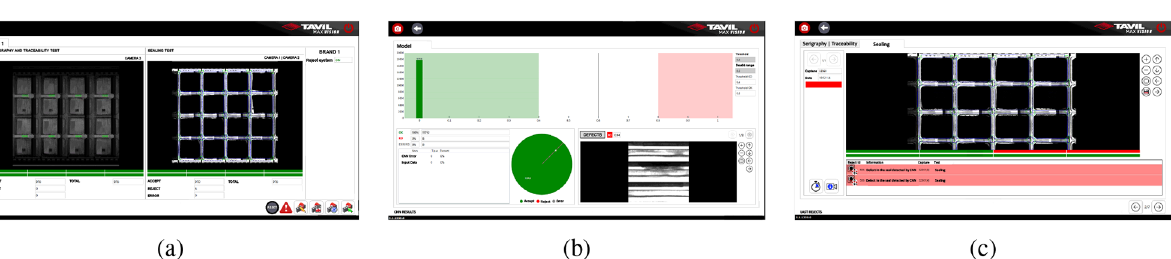
Figure 7. Interfaces of the control and image processing software with ( a ) the main window of the software, which shows the production in real time, the test results for each analyzed step (the serigraphy and traceability test on the left and the sealing test on the right), and the total counters; ( b ) the CNN Inference Statistics window, which shows the last input images labeled as rejected by the model, the total counters, the decision threshold and doubt range, and the graphically represented historical probability; and ( c ) the Last Rejected Steps window, which shows the result of the last steps rejected by a